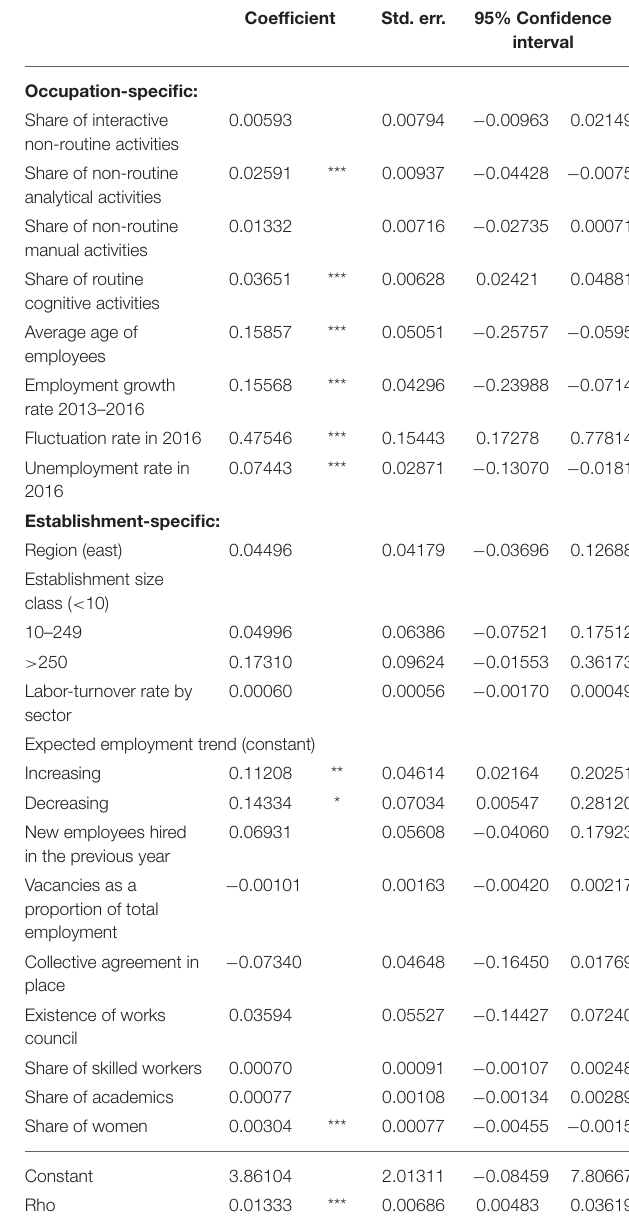
TABLE 6 | Estimation results: increasing requirements regarding short-term flexibility in working time. Coefficient Std. err. 95% Confidence